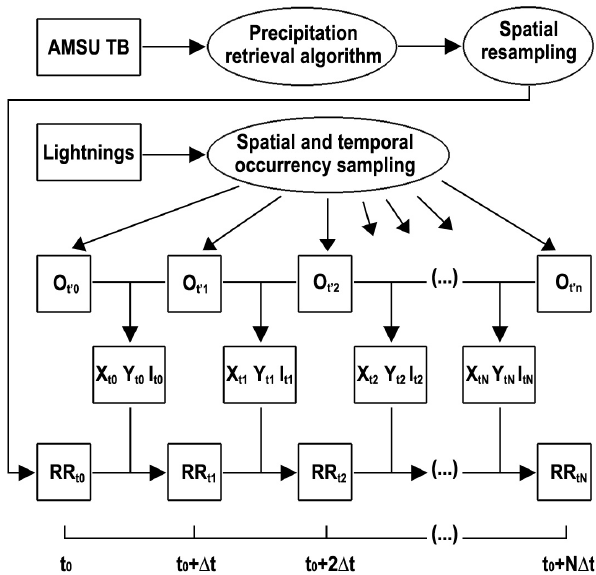
Fig. 3. (a and b) Example of lightning occurrence matrix O tn and O tn + 1t showing, in different colours, three different 8-connected cells O tn (a) and the corresponding cells s tn + 1t (b) . The numbers indicate the lightning occurrences in the various 5.33-km resolution pixels of the three cells. (c and d) Corresponding portion of the translation matrix X tn and Y tn in the cross-track and along-track direction,